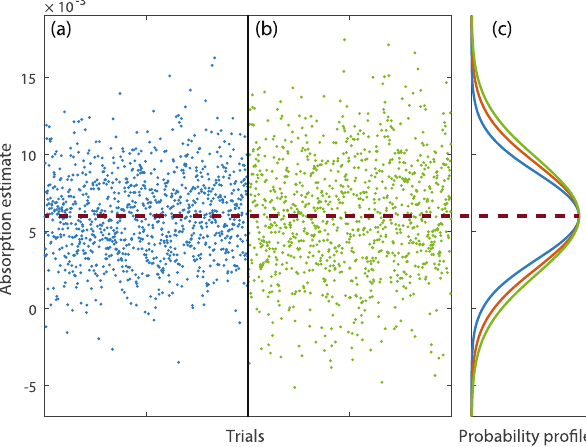
Figure 3. Illustrating the improvement achieved using two-photons compared to single photons in practice. ( a ) Data points each obtained with a single acquisition of correlated two-photon states captured by the CCD and analysed with our estimator eq. (2). ( b ) Data points each obtained with a single acquisition of single-photon states and with the direct and sub-optimal estimator eq. (1). Both data in ( a ) and ( b ) are each from 1,000 individual absorption estimates ( α s = 5.99 · 10 − 3 which is obtained with only the HWP as a sample). ( c ) The distributions of these data are compared by fitting Gaussian functions—the narrower blue curve corresponds to ( a ), the wider green curve corresponds to ( b ). The intermediate red curve corresponds to the expected distribution of estimates that would occur with a perfect coherent state measured with 100% efficient and noiseless detection. The three distributions are presented with different normalisations so that their maximum are superposed along the horizontal axis to highlight the difference in